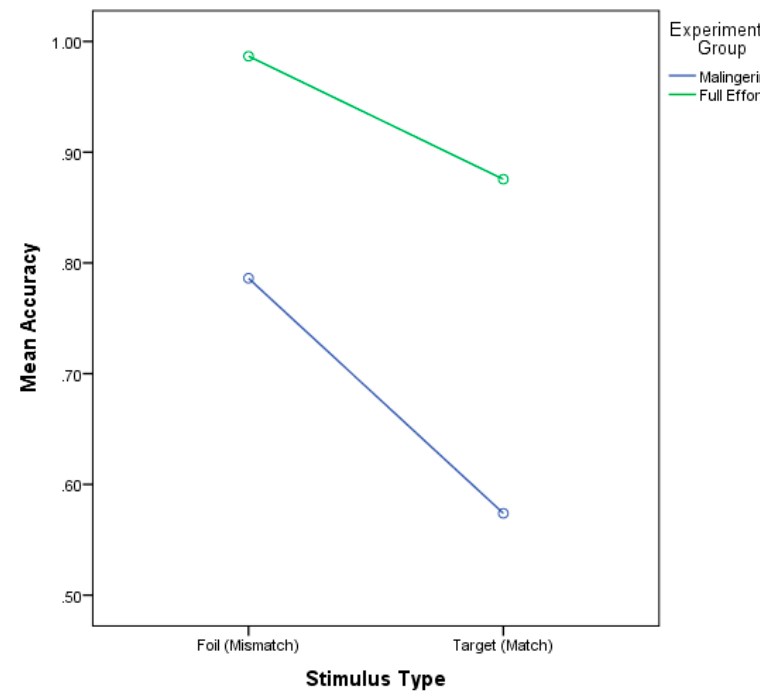
Figure 2. Mean accuracy percentage for each stimulus type by group.